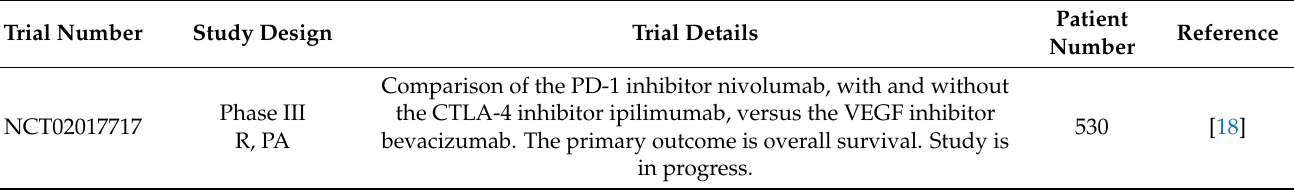
Table 1. Overview of current and in-progress immunotherapeutic clinical